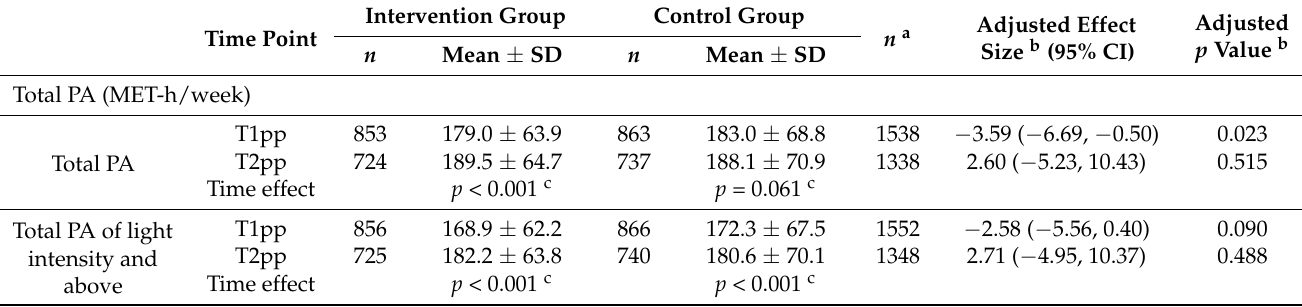
Table 5. Postpartum physical activity behaviour in the intervention and control